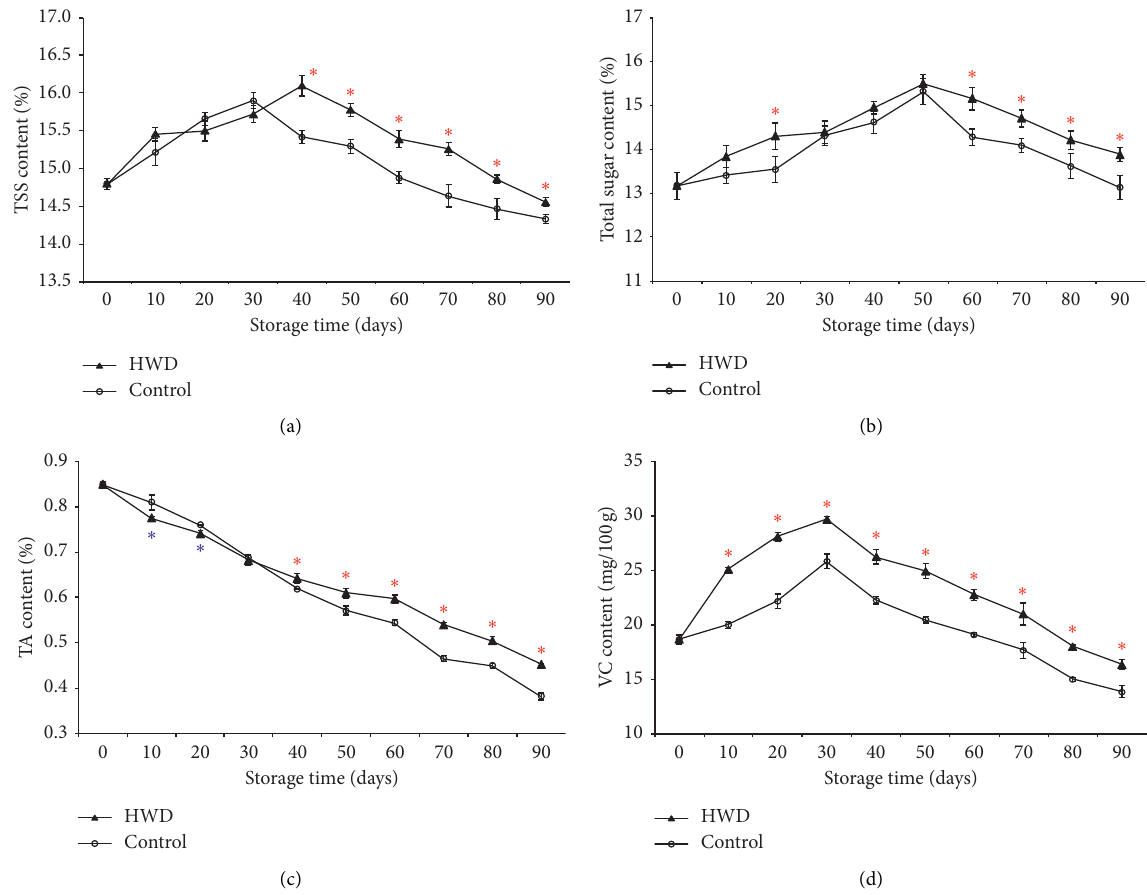
Figure 2: Effects of HWD on the contents of TSS (a), total sugar (b), TA (c), and VC (d) of “Nanfeng” mandarin during 90 days of cold storage at 6 ± 0.5 ° C. The symbols “ ∗ ” and “ ∗∗ ” represent significantly higher and lower values for the HWD-treated fruits than the control fruits, respectively. The significant difference was determined according to the independent-samples t -test ( P < 0 . 05) on each storage day.